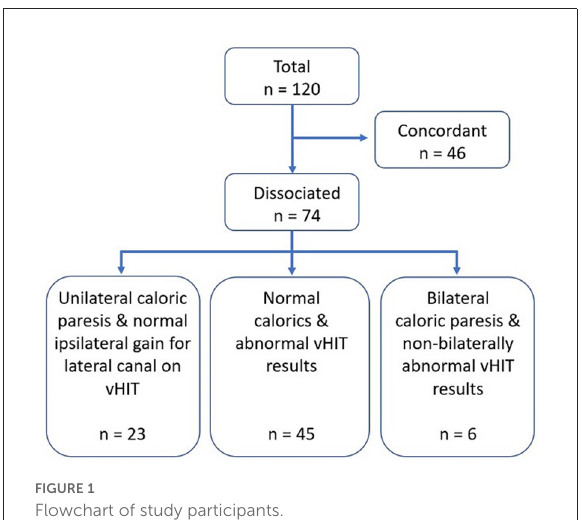
FIGURE1 Flowchart of study